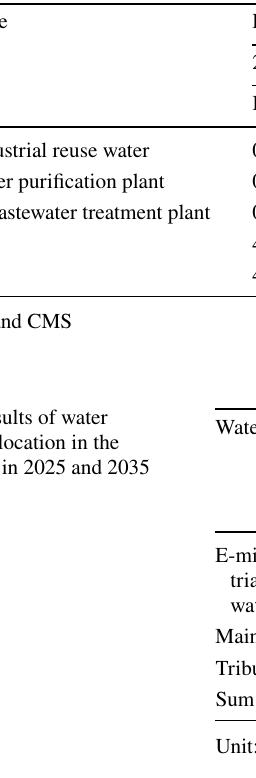
Table 10 Results of water resources allocation in the f-mine area in 2025 and 2035